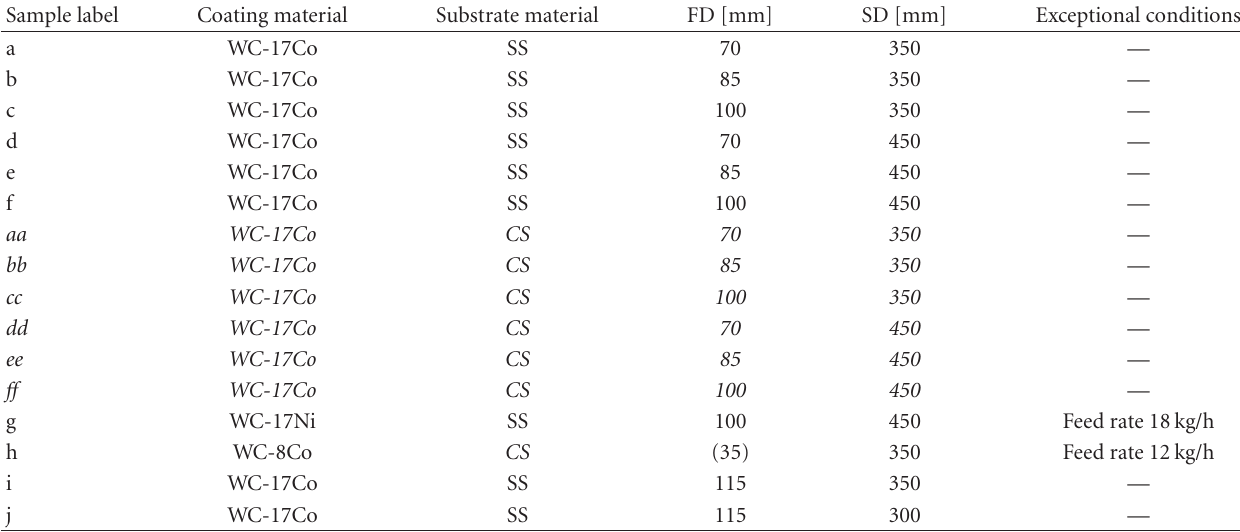
Table 1: Samples of WC-based coatings.